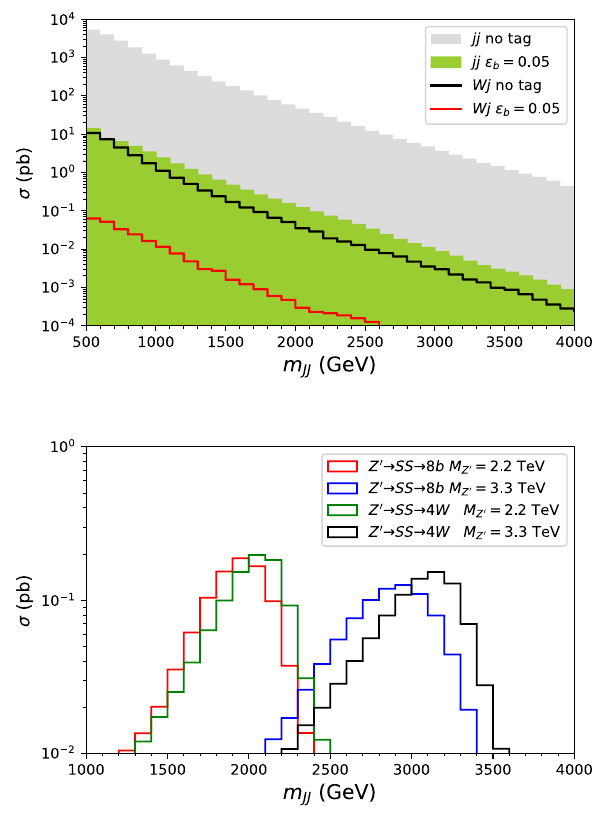
Fig. 9 Top: J J invariant mass distribution for the QCD dijet ( jj ) and W j backgrounds before and after jet tagging. Bottom: The same, for the signals before jet tagging, with exclusive mass